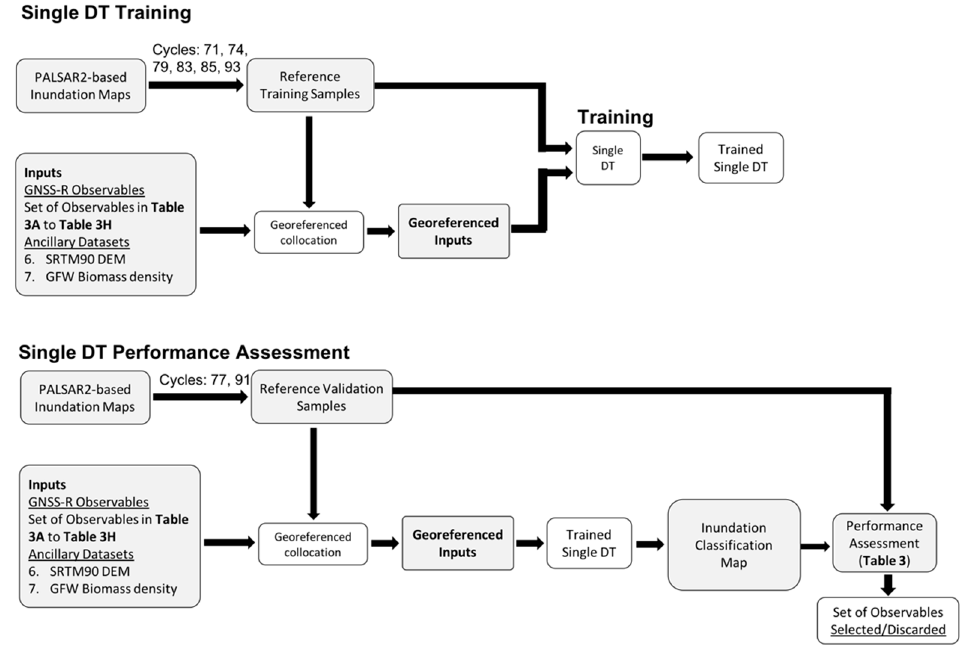
Figure 8. Flowchart showing the single decision tree (single DT) methodology based on classification trees built from standard CART [54]. In the top, the training samples for the set of GNSS-R observables defined in Table 3A to Table 3H, the ancillary datasets (aboveground biomass, elevation), and the PALSAR-2-based reference inundation maps were used to create a single DT for each row in Table 3. In the bottom, the validation samples for the same set of GNSS-R observables and ancillary datasets (aboveground biomass, elevation) were input to the trained Single DT to create inundation classification maps. The output was then compared to the PALSAR-2-based reference validation inundation maps to assess the accuracy of the classification results.